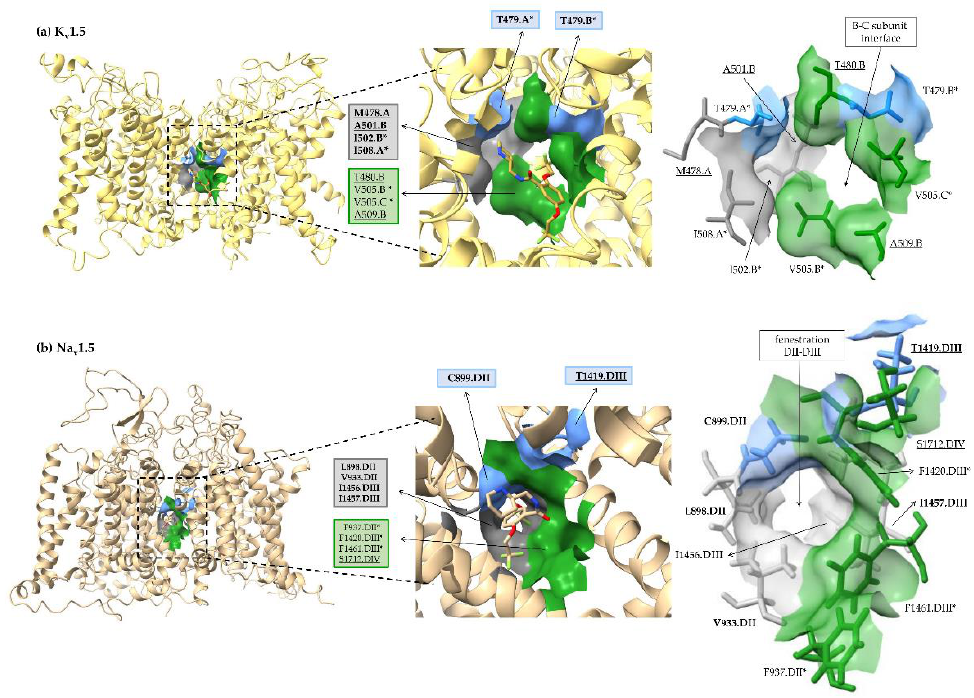
Figure 7. Mapping onto tertiary structure the equivalent residues in flecainide BS . Surface representation of the equivalent residues in flecainide BS in ( a ) K v 1.5 and ( b ) Na v 1.5 as predicted by PocketAlign (listed in Table 4). Residues from the hydrophobic patch are shown in gray surface and they are labeled inside a gray box meanwhile those from the hydrophilic region are highlighted in light-blue and included in a box with similar color. The rest of equivalent residues are presented in green surface and they are enclosed in a green box. The equivalent residues with a similar physicochemical nature are highlighted in bold. –– The * is used to denote residues relevant for flecainide binding according to mutagenesis in K v 1.5 and cryo-EM flecainide-bound structure in Na v 1.5. The underlined residues were not previously reported in flecainide BS. Flecainide is shown in sticks and colored per element with oxygen atoms in red, nitrogen atoms in blue, fluorine atoms in green and carbon atoms in sand color.